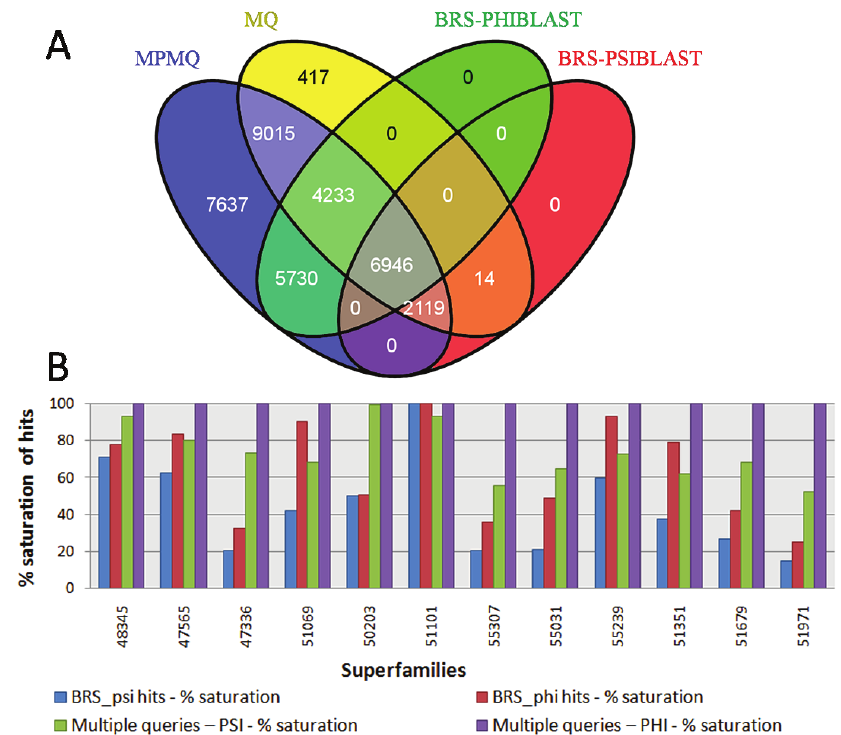
Figure 4. ( A ) Venn diagram representing four sets MPMQ (Multiple Pattern-Multiple Query), MQ (Multiple Query), BRS (Best Representative Sequence) from PHI-BLAST and BRS from PSI-BLAST comprising of all hits combined for 12 superfamilies. ( B ) Comparison of MPMQ and MQ with respective BRS-TP (Best Representative-True Positives). The blue and green bars correspond to TP obtained for BRS (BRS-TP) and cumulatively (Cum-TP) using all queries in the superfamily respectively using PSI-BLAST. The red and purple bars correspond similarly to TP obtained for BRS (BRS-TP) and cumulatively (Cum-TP) for all queries in the superfamily respectively using PHI-BLAST. All values are % saturation considering Cum-TP for PHI-BLAST (highest number of TP) as the saturation value for each superfamily.